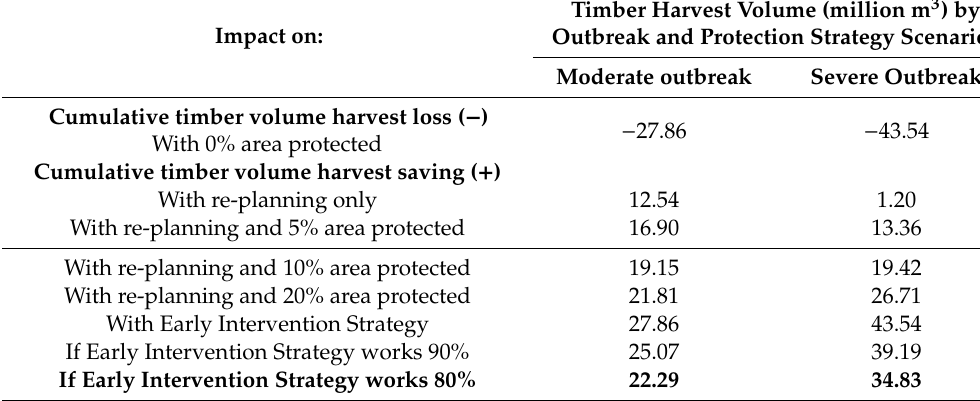
Table 1. Summary of available harvest volume impact (cumulative from 2017 to 2067) on Crown land in New Brunswick from moderate and severe spruce budworm outbreak